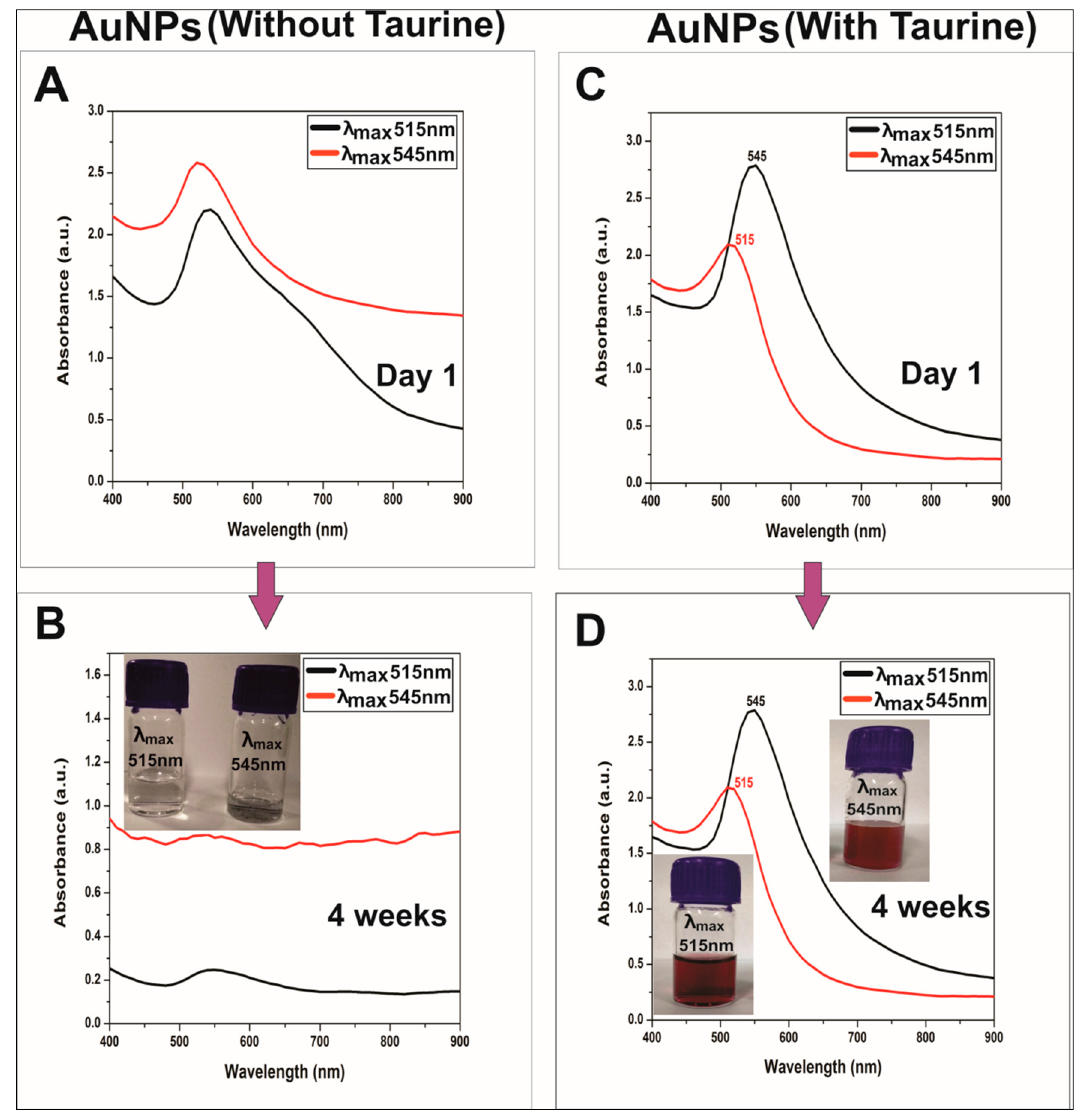
Figure 2. Optical spectroscopy and stability of gold nanospheres absorbing at 515 nm and 545 nm synthesized with / without taurine. Control samples (without taurine) showed aggregation within four weeks, as shown in ( B ). ( A ) show the formation of gold nanospheres on day one, but the shoulder peaks indicate a slight aggregation within the control samples. In contrast, the gold nanospheres capped with taurine had stable tunable plasmon bands from day one up to four weeks, as shown in ( C , D ). The inset images show the disappearance of color for the gold nanoparticle solutions without taurine, whereas the nanoparticles capped with taurine maintained stable colloidal gold nanoparticle solutions for up to four weeks.